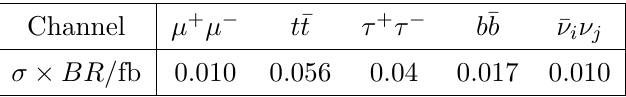
p Table 2 . HL-LHC ( s = 14 TeV) minimum (cid:12)ducial cross section times branching ratios